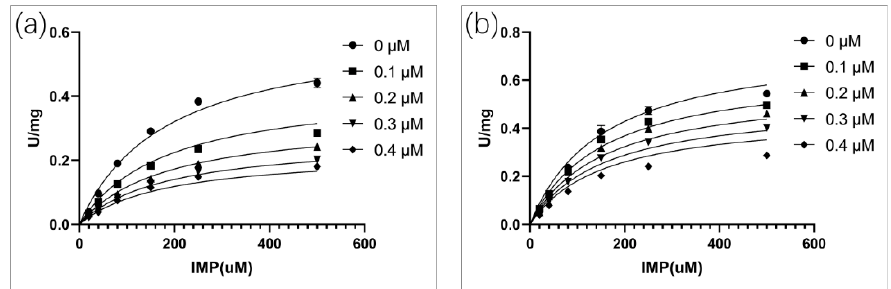
Figure 5. Inhibition kinetics at different concentrations of compounds by varying the IMP concentrations at a fixed NAD + concentration. ( a ): Bronopol; ( b ): Disulfiram.